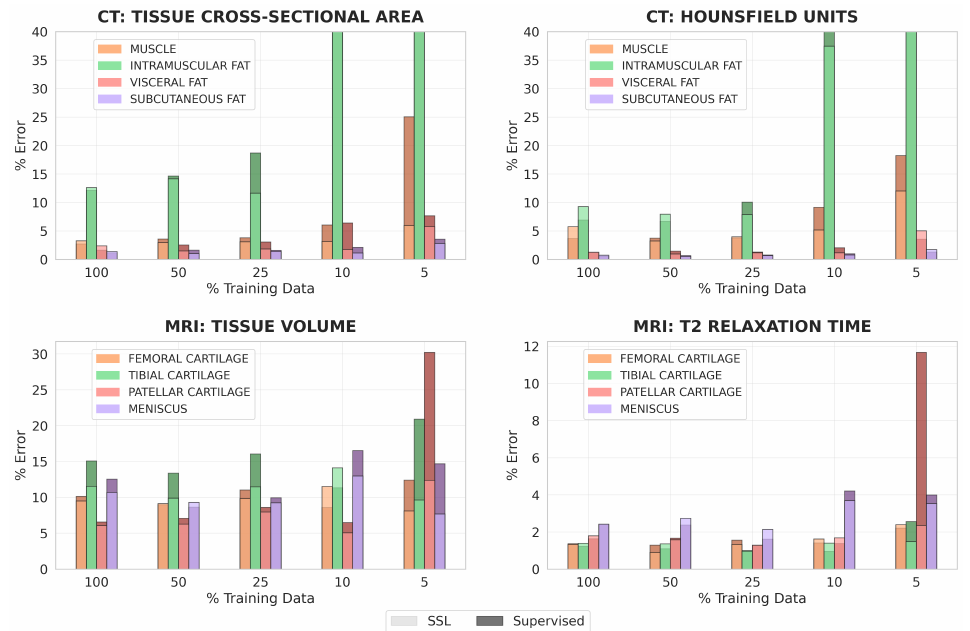
Figure 6. A comparison of the percent error in calculating clinical metrics for the MRI and CT datasets between when the tissue segmentations are generated by fully-supervised models and when the tissue segmentations are generated by optimally trained models, pretrained using 200% data for MRI and 1200% data for CT. Each bar represents the median percent error across the test set for a particular tissue, clinical metric, and label regime. The percent error in the calculation of tissue cross-sectional area and mean HU for intramuscular fat extends beyond the limits of the y-axis when 10% and 5% labeled training data for segmentation is